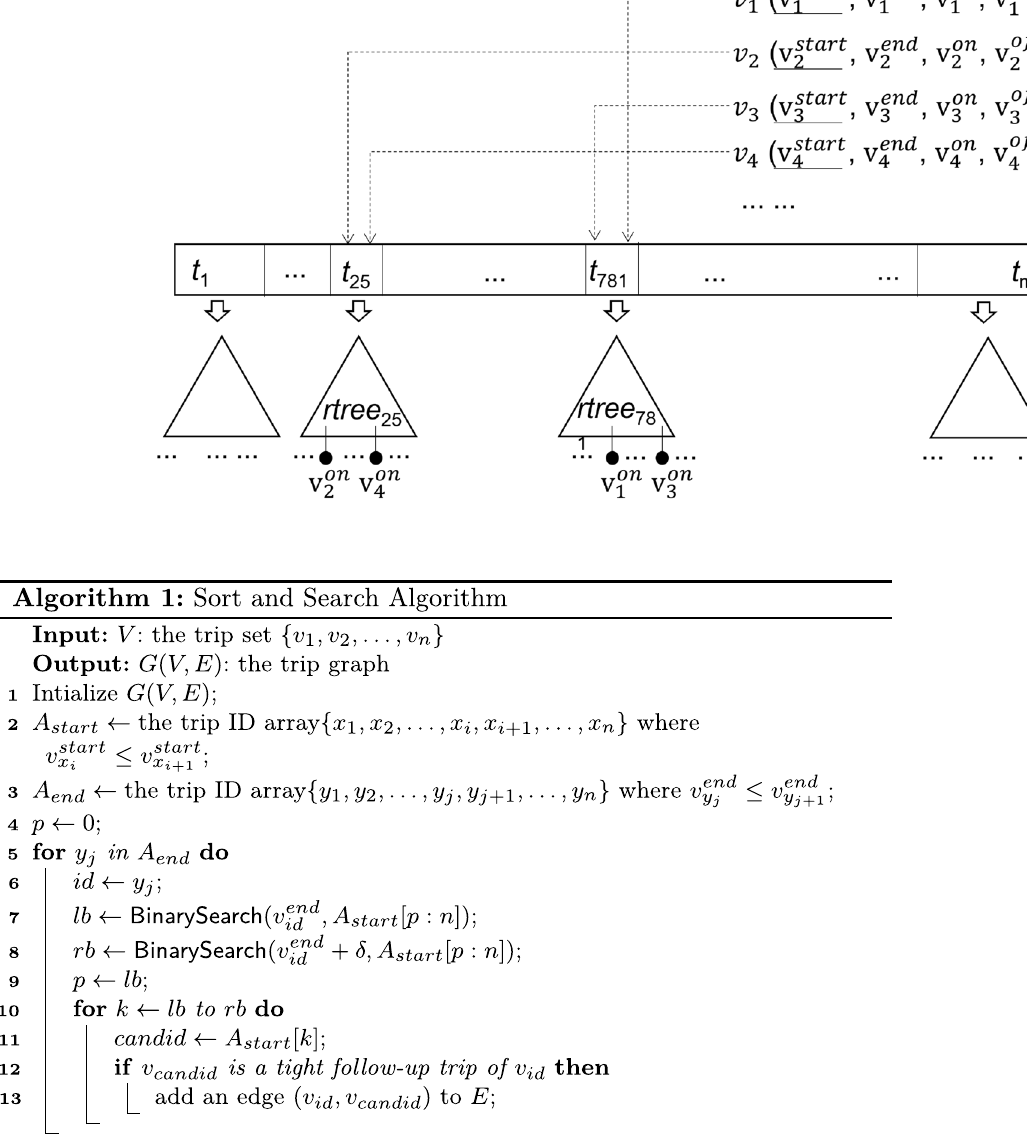
Fig. 4 An example of time slot R ∗ -tree